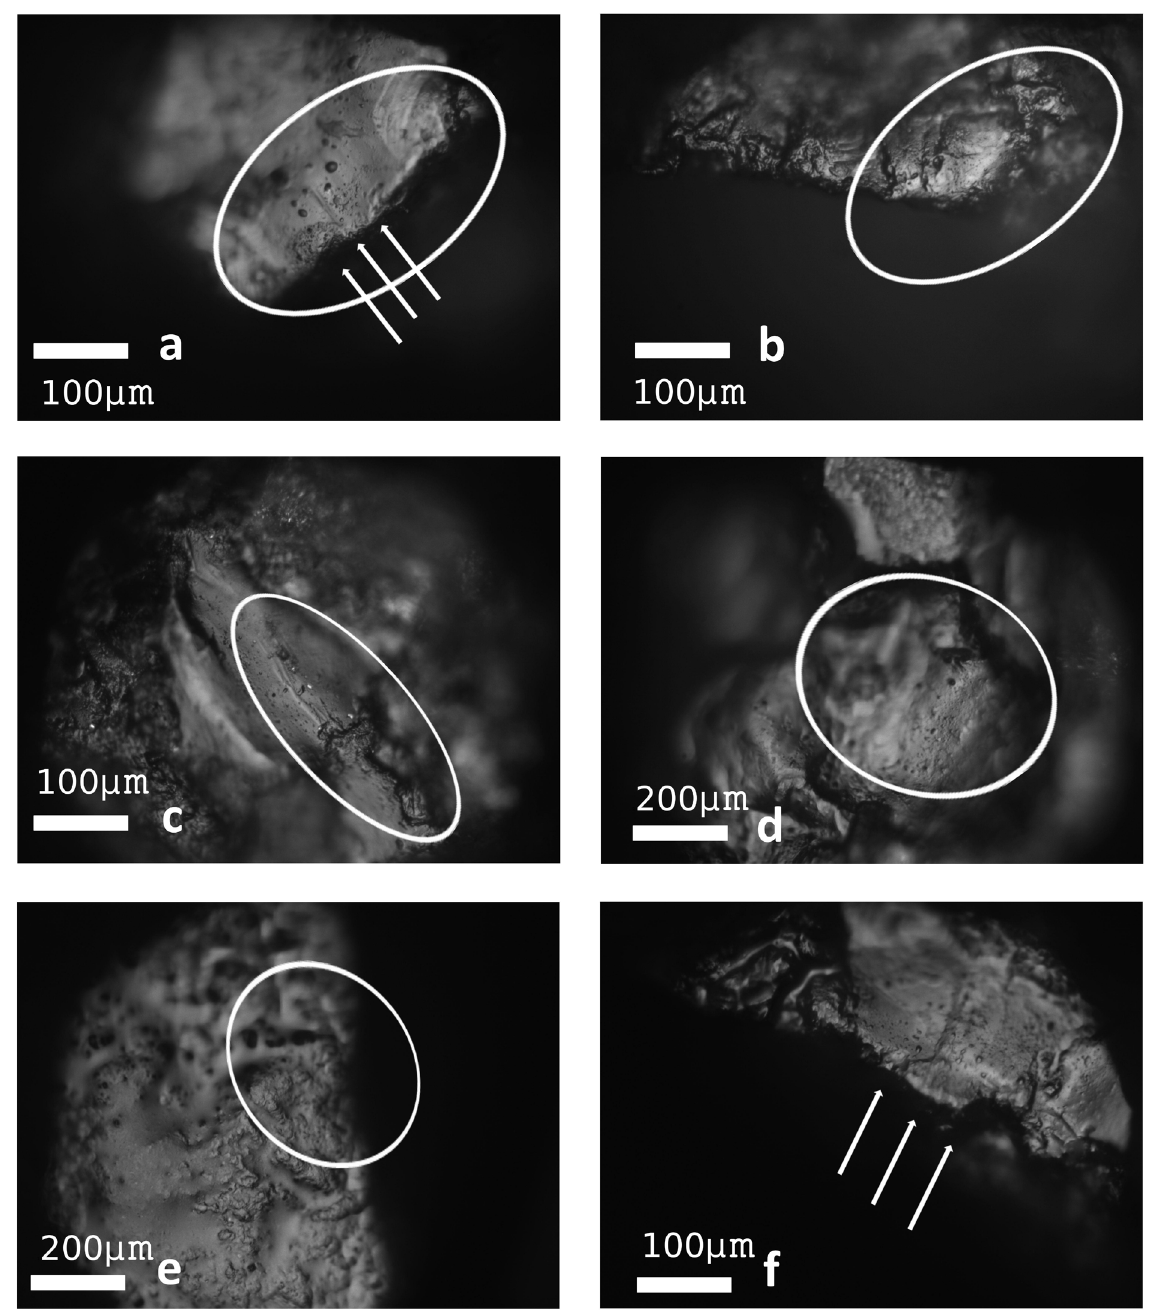
Figure 7. Use wear traces on Lagoa do Bando lithic artifacts: (a) Levallois flake B* 12 with wood-working traces on the edge; (b) Levallois flake P 1 with well-developed meat-working traces; (c) Discoid flake B* 75 with wood-working traces on the edge; (d) Edge of the Levallois Flake B* 35 wood-working traces; (e) Edge of the Levallois Flake P 6 with meat-working traces; (f) Discoid flake B* 60 with butchering traces on the